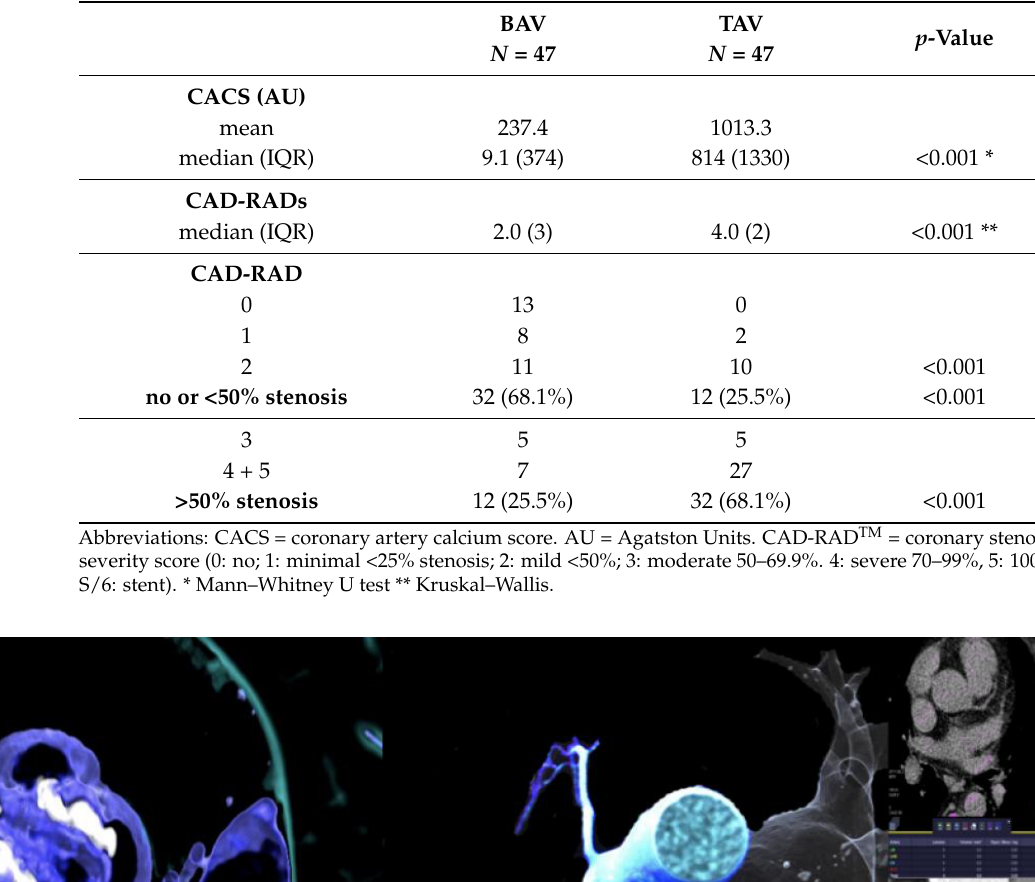
Table 2. Coronary artery calcium score (CACS) and coronary artery disease profile by CTA.